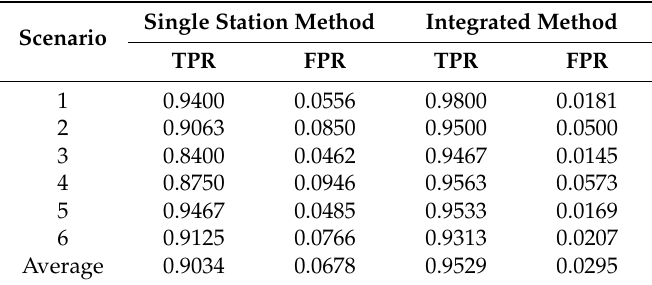
Figure 6. Performance comparison between the single station method based on the Autoregressive (AR) model and fusion method combining temporal and spatial information (time sequence). The first sub-figure shows the test data and events (marked with squares). The second sub-figure shows the detection result of single station method based on the AR model. The third sub-figure shows the detection result of the fusion method using both temporal information and spatial information. Table 2. Performance comparison between the single station method based on the AR model and fusion method, combining temporal and spatial information (TPR, FPR).